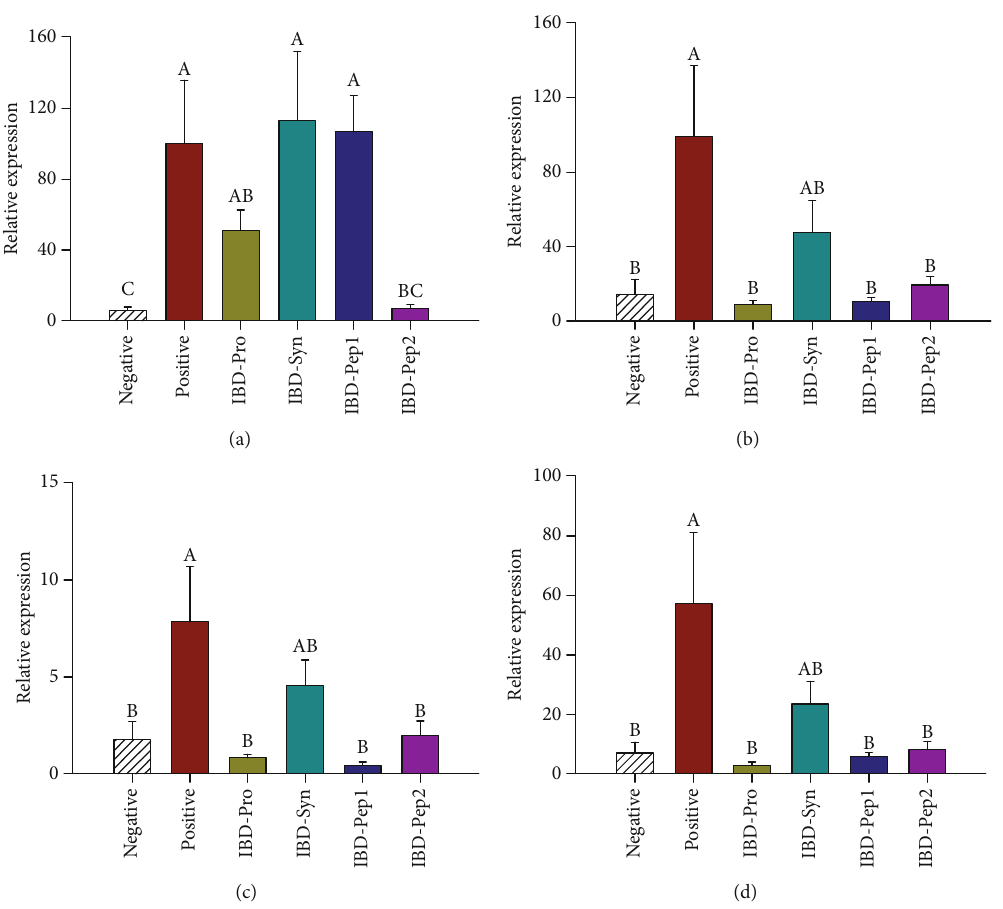
Figure 3: In fl ammatory cytokine mRNA levels in the large intestine tissue: (a) IL-1 β , (b) IL-6, (c) TNF- α , and (d) COX-2. A,B,C Values are signi fi cantly di ff erent ( p < 0 : 05